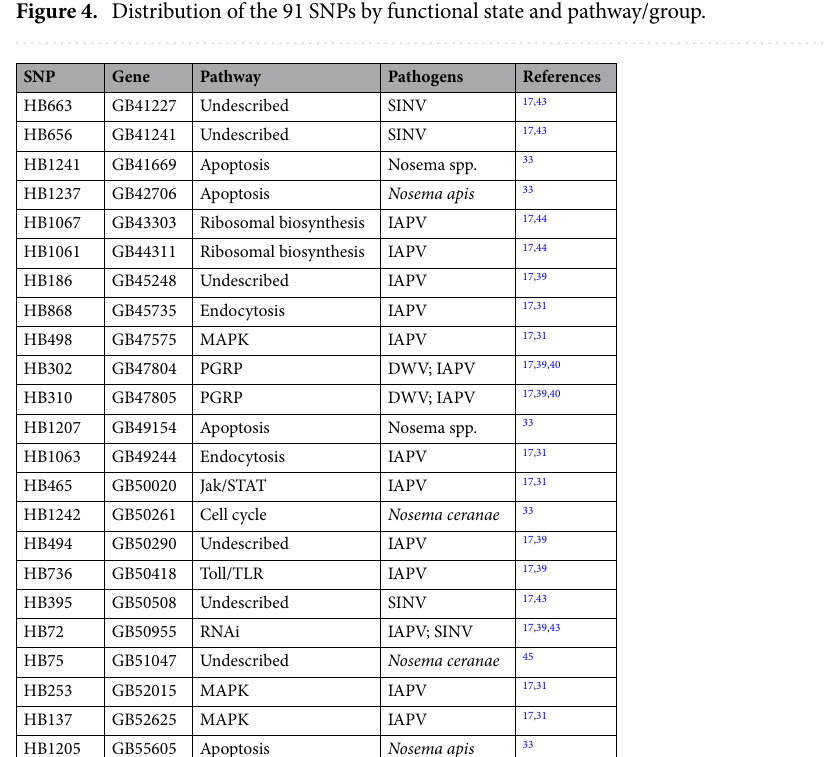
Figure 4. Distribution of the 91 SNPs by functional state and pathway/group.